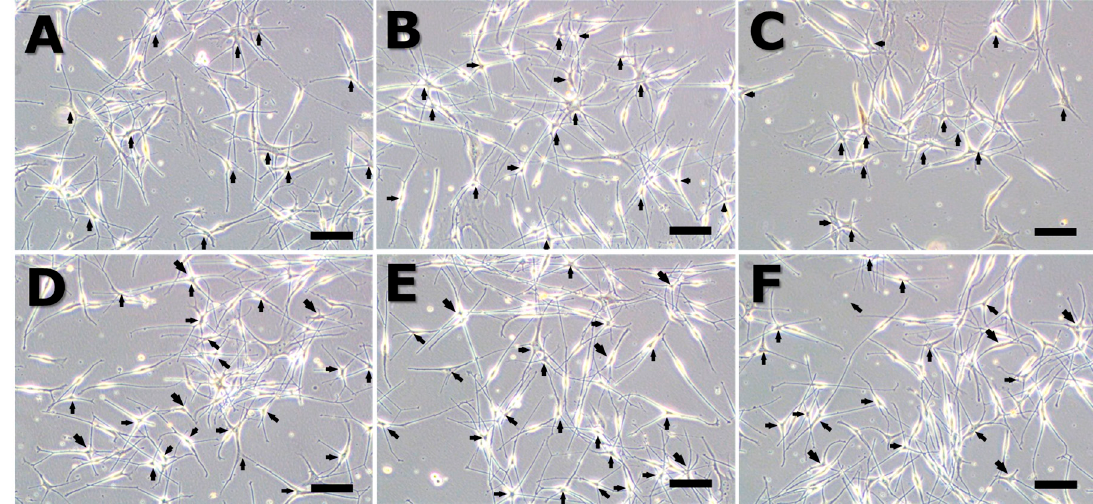
Figure 2. Melanocyte morphology after stimulation by an extremely low frequency electromagnetic field (ELF-EMF) for 72 h. All groups were cultured in M254 media. Before ELF-EMF exposure, cells were cultured in modified M254 media containing forskolin, melanocyte-stimulating hormone ( α -MSH), and 12- O -tetradecanoyl-phorbol-13-acetate for 72 h. After culturing in differentiation media, cells were treated with continuous ELF-EMFs. The α -MSH group was cultured in M254 media added to 5 nM α -MSH. ( A ) control; ( B ) α -MSH; ( C ) 30 Hz; ( D ) 50 Hz; ( E ) 60 Hz; and ( F ) 75 Hz. Original magnification was ×100; bar = 100 μ m.